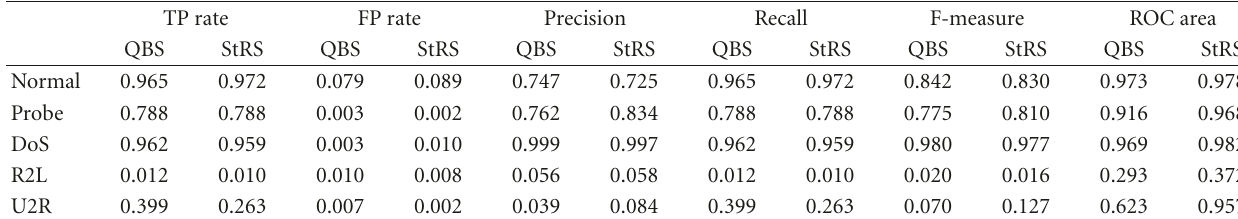
Table 5: Detailed accuracy by class of the test dataset.